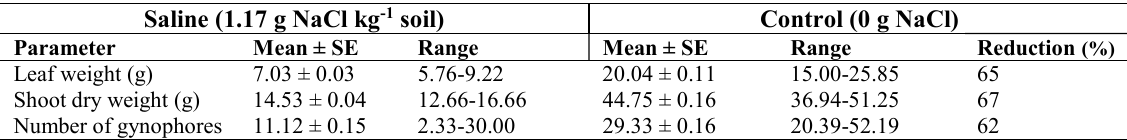
Table 1. Mean of different parameters under saline and control conditions of 275 groundnuts in